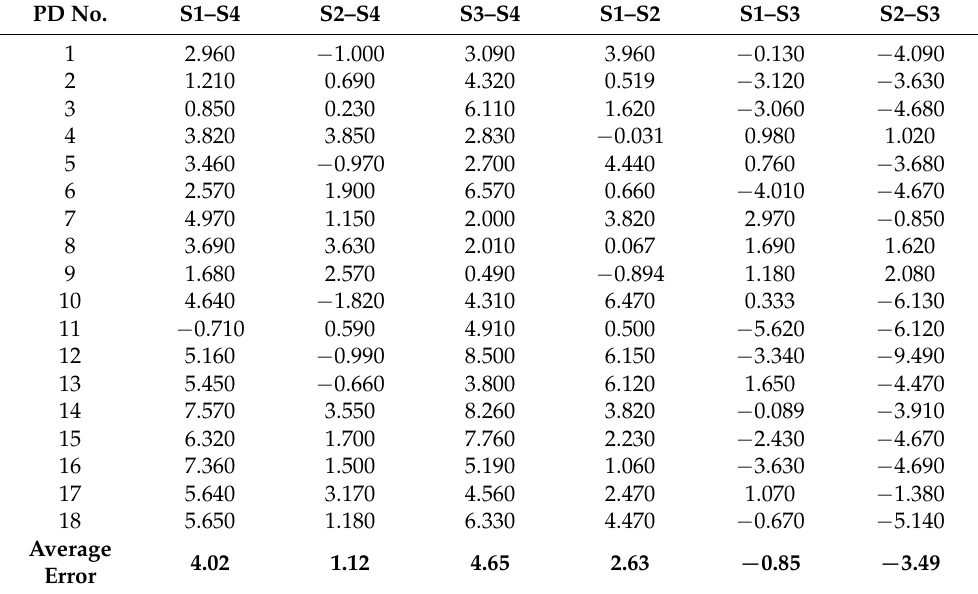
Table 5. Error Produced by comparing expected TDOA with CEM estimated in (ns). PD